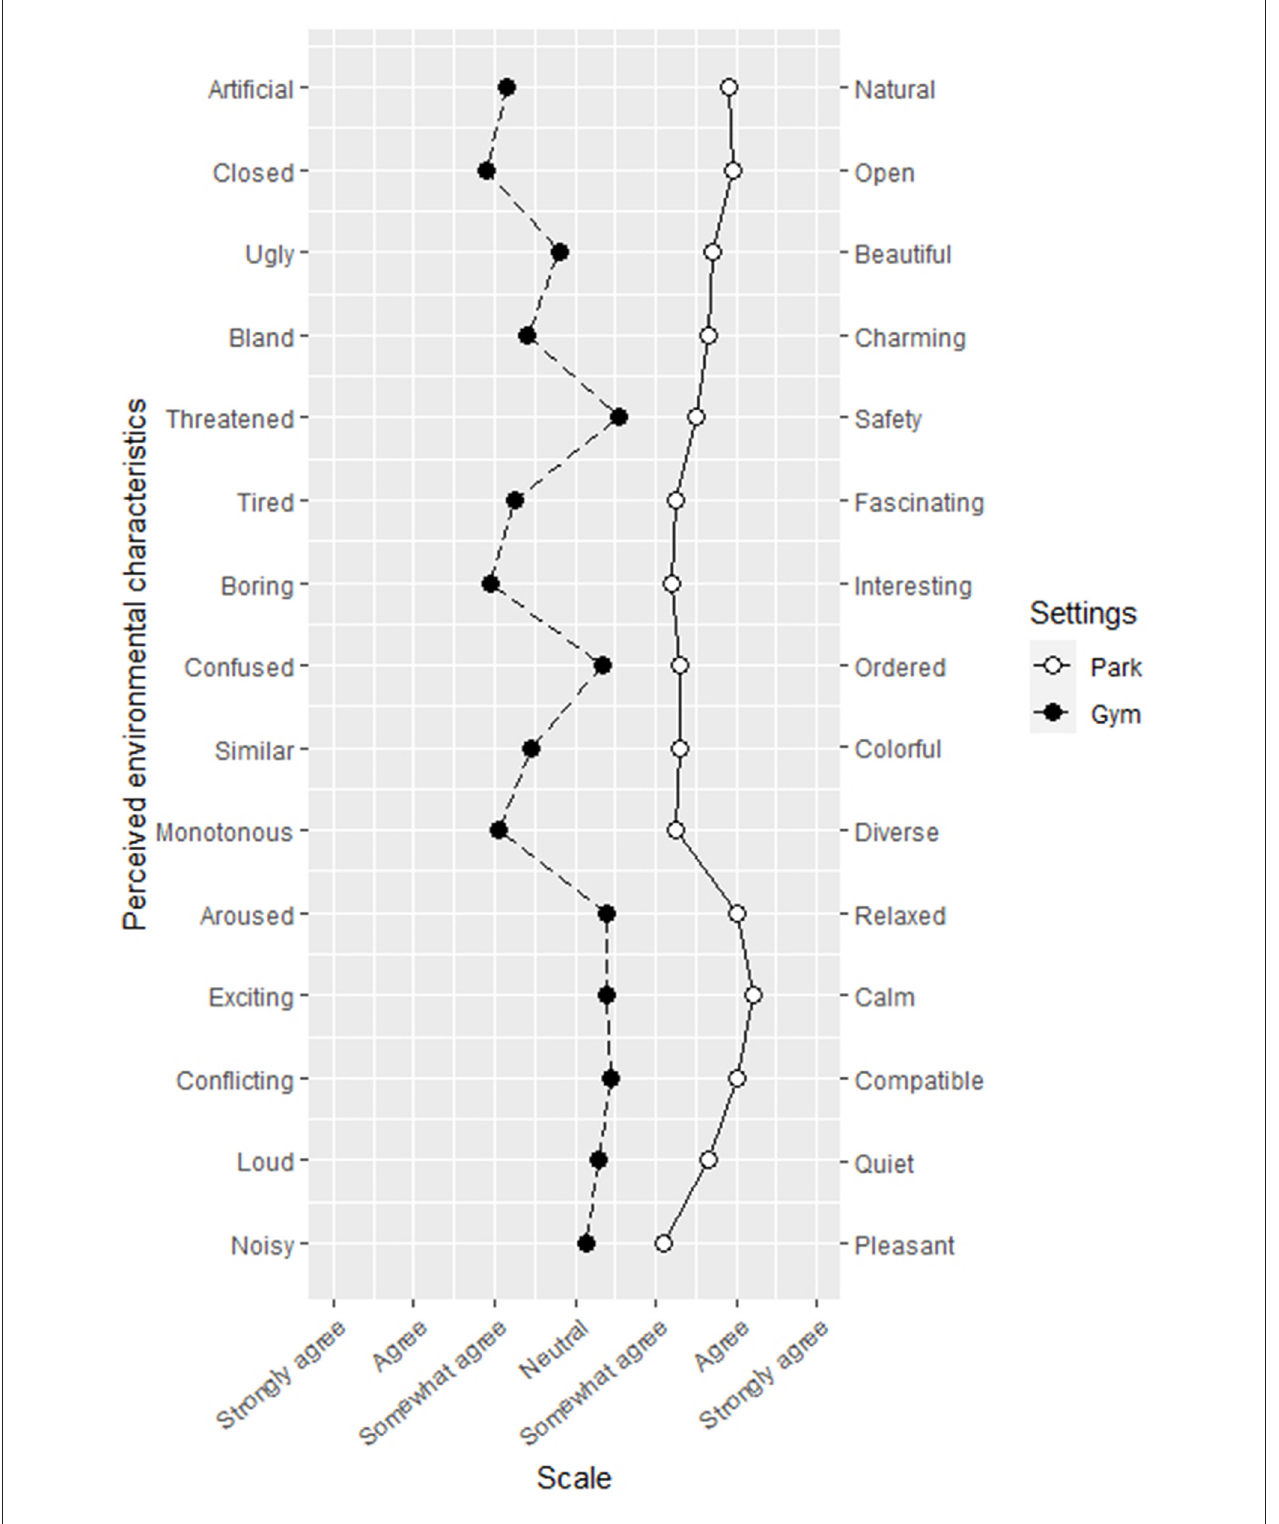
FIGURE 6 | Measurements for the perception of park and gym settings while walking slowly using semantic differential scales.